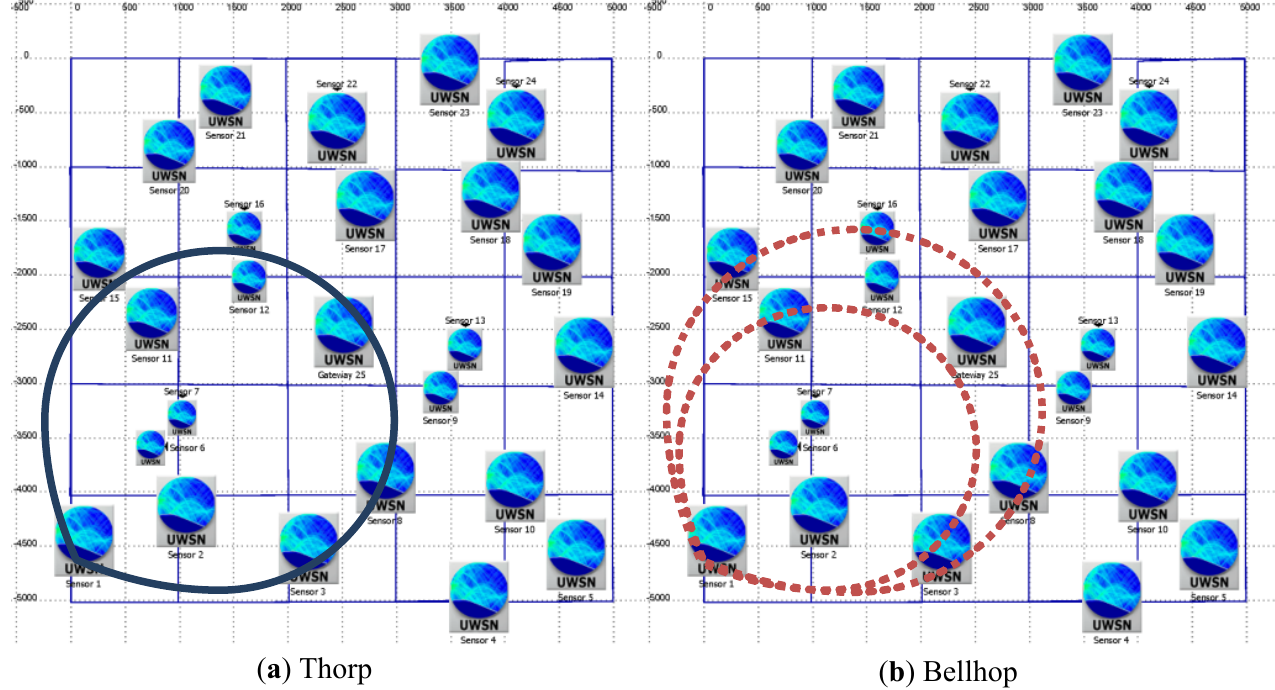
Figure 9. Gateway reachability (central node) from Node #1 (bottom leftmost